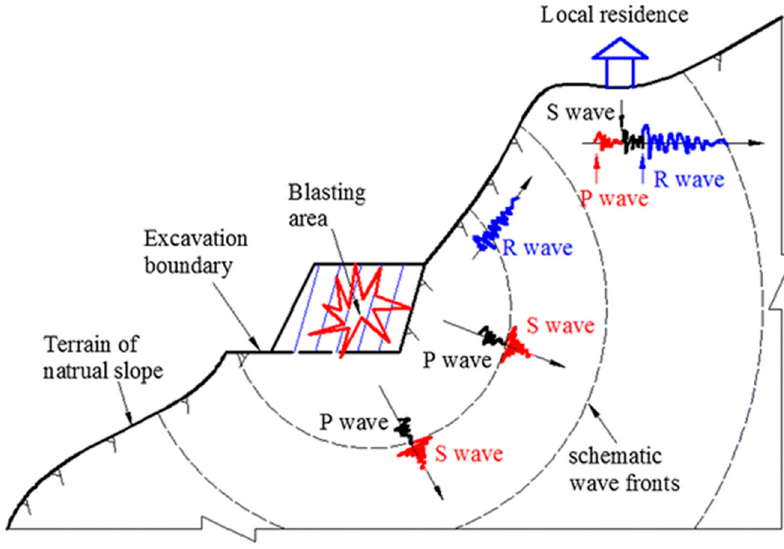
Figure 2. A view of the P, S, and R waves generated by blasting.